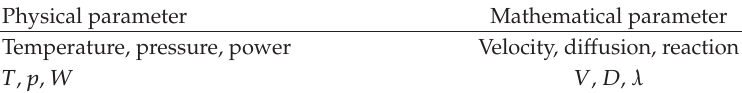
Table 4: Physical and mathematical